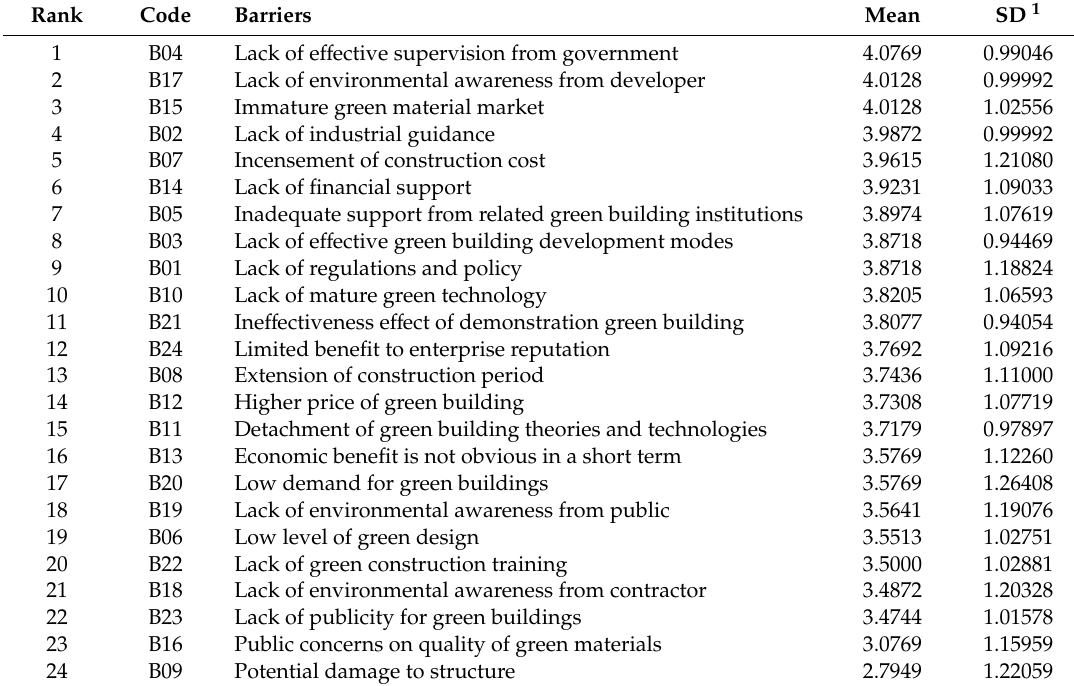
Table 3. Ranking of the potential barriers.